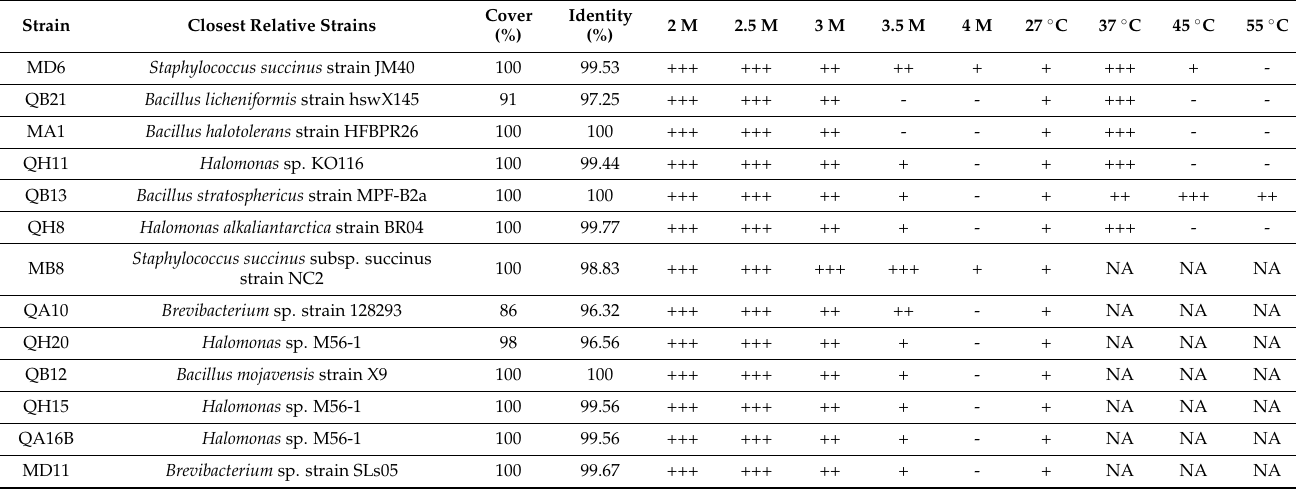
Based on morphological differences a total of 50 bacterial colonies underwent NaCl selection as described in the Section 2. Among the 50 initially isolated colonies, resistant to 500 mM NaCl both from maize (25) and quinoa (25), only 13 colonies showed different degrees of resistance, as illustrated in Table 4. Table 4. Growth of NaCl resistant bacterial strains, identified by 16S rDNA sequencing, at difference sodium chloride concentration and different temperature.